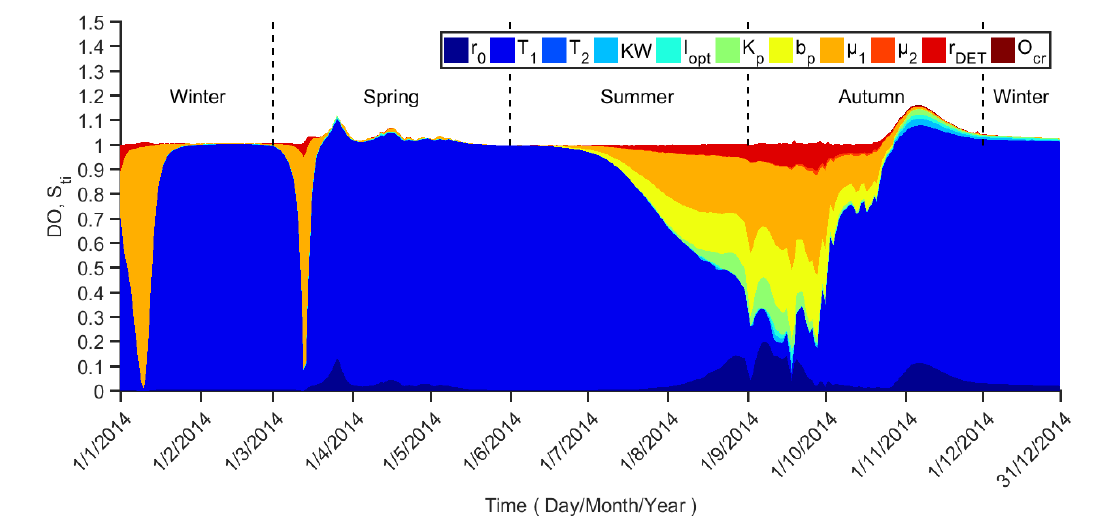
Figure 6. S ti profiles for DO